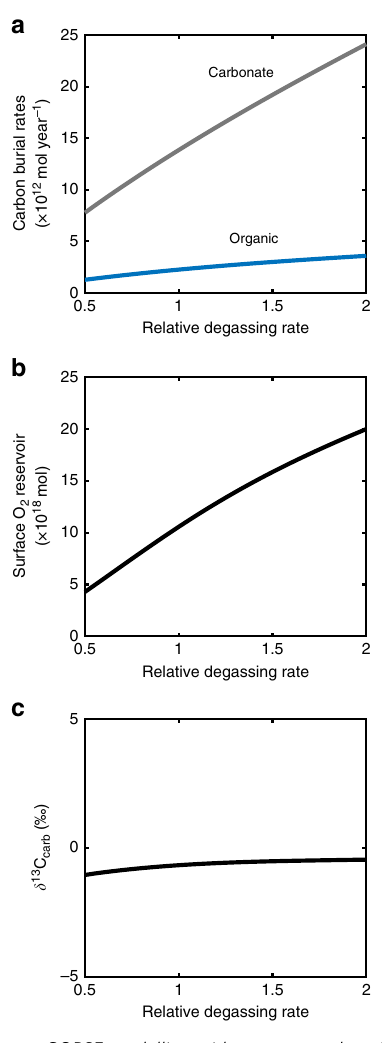
Fig. 3 Steady-state COPSE modelling with respect to changing degassing inputs (D). a Organic carbon and carbonate carbon burial rates. b Atmosphere and ocean O 2 (moles), c ð 13 C carb . All model forcings are held constant at 541 Ma, with the model allowed to stabilise for 10 Gyrs